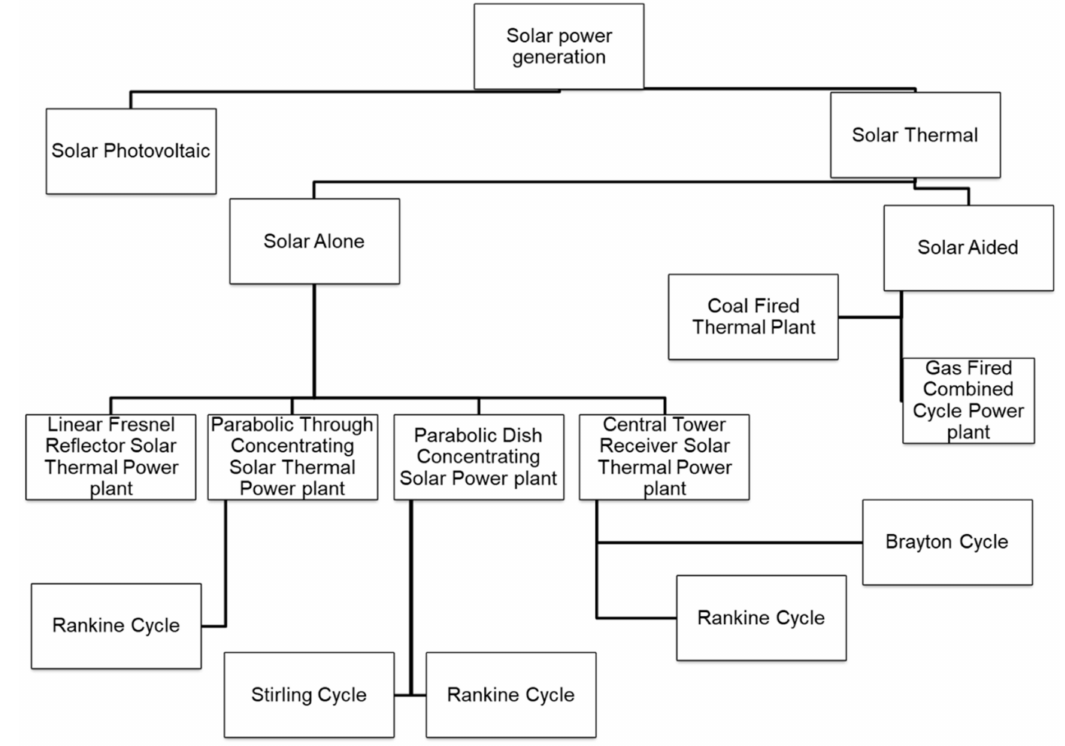
Figure 2. Solar power